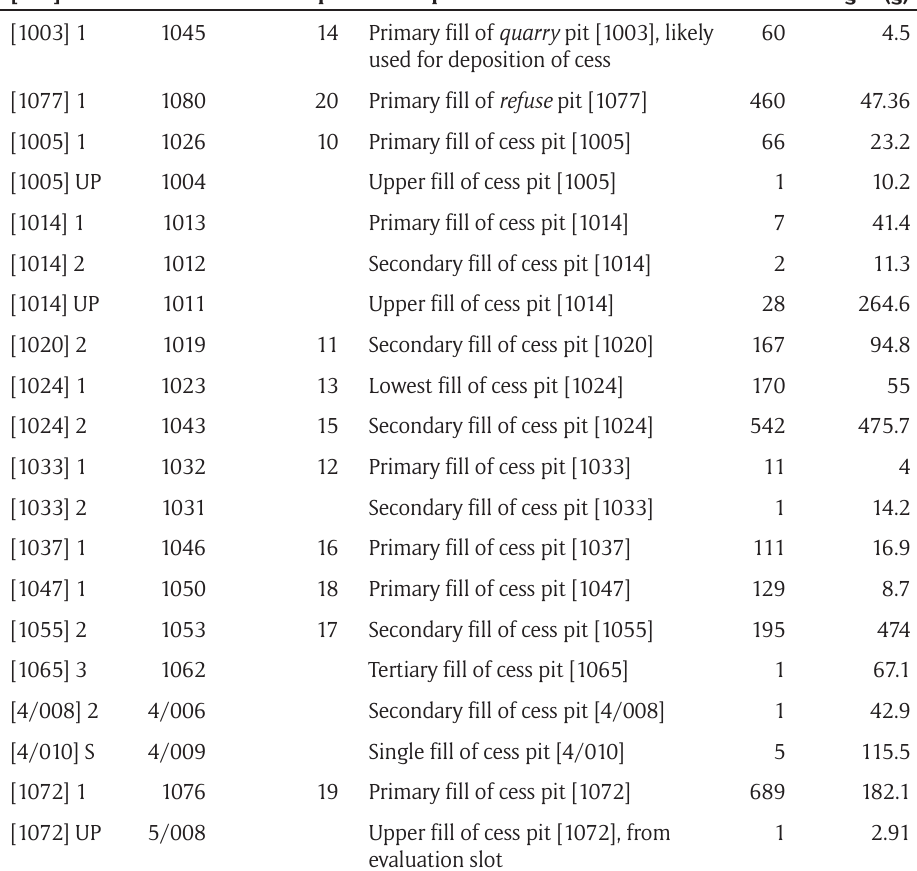
Table 1: Zooarchaeological assemblage from 1–5 Benjamin Street by context. Contexts are arranged by period, and grouped within those periods based on their parent context. The [Cut] is used in graphical